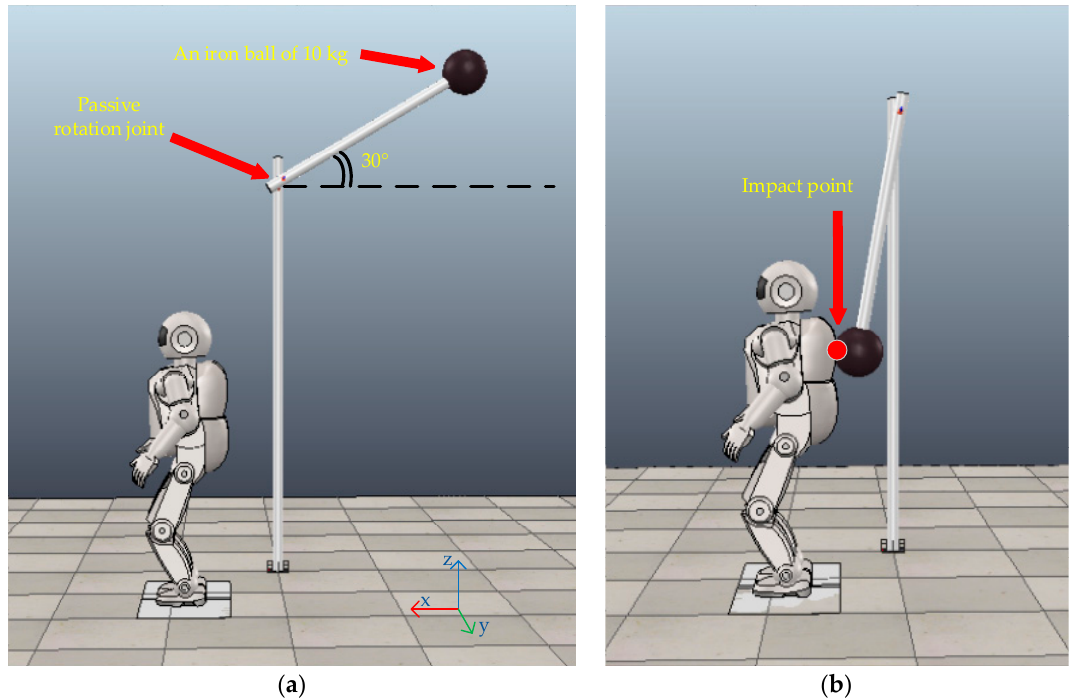
Figure 3. Biped robot in the simulation environment. ( a ) At the start of simulation, the pendulum is in its reset state, i.e., it is inclined upward at an angle with the ground of thirty degrees. ( b ) The pendulum with an iron ball accelerates and falls under the influence of gravity. When the back of the robot detects that the ball has struck the robot, the agent starts to interact with and learn the environment.